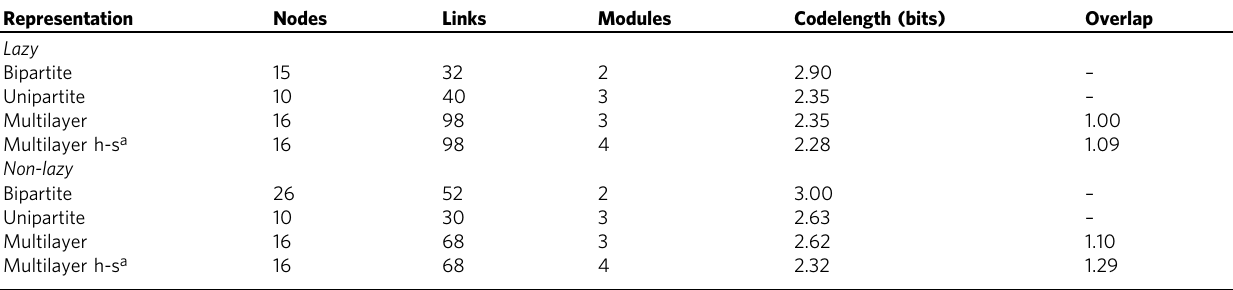
Table 1 Optimal fl ow-based communities of the schematic hypergraph in Fig. 1a represented with different networks.